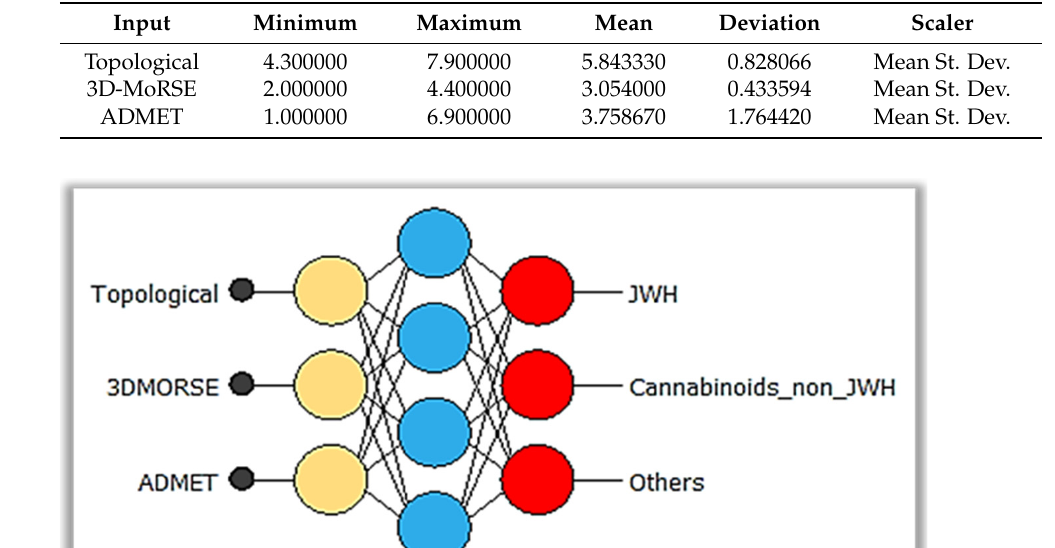
Table 1. Values used for scaling the inputs for all ANN versions.